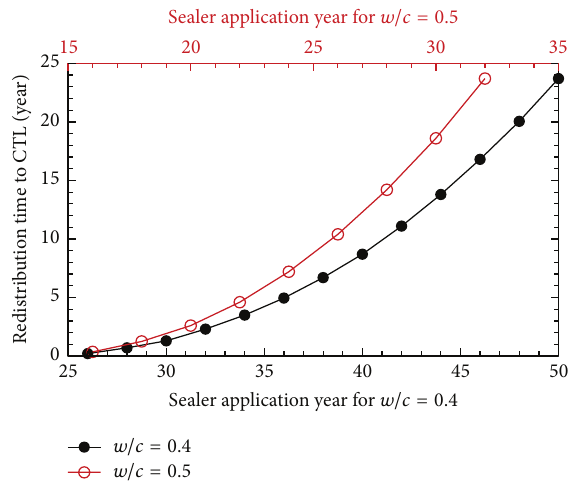
Figure 8: The evolution of the CTL depth (left vertical axis) and the chloride concentration at the minimum cover depth (80 mm) (right vertical axis). For each quantity, two scenarios, that is, unsealed and a sealer applied at the outer surface when 𝑡 = 40 years, are plotted. 𝑅 = 0 . 4 m. 𝑤/𝑐 = 0 . 4.